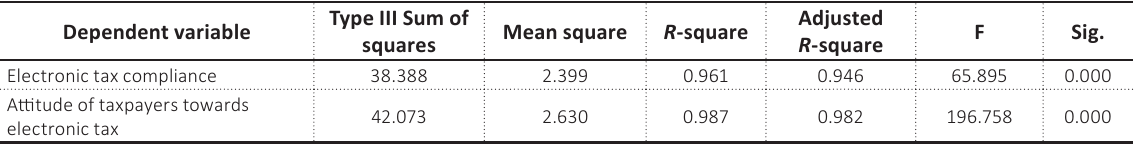
Source: Researchers’ field